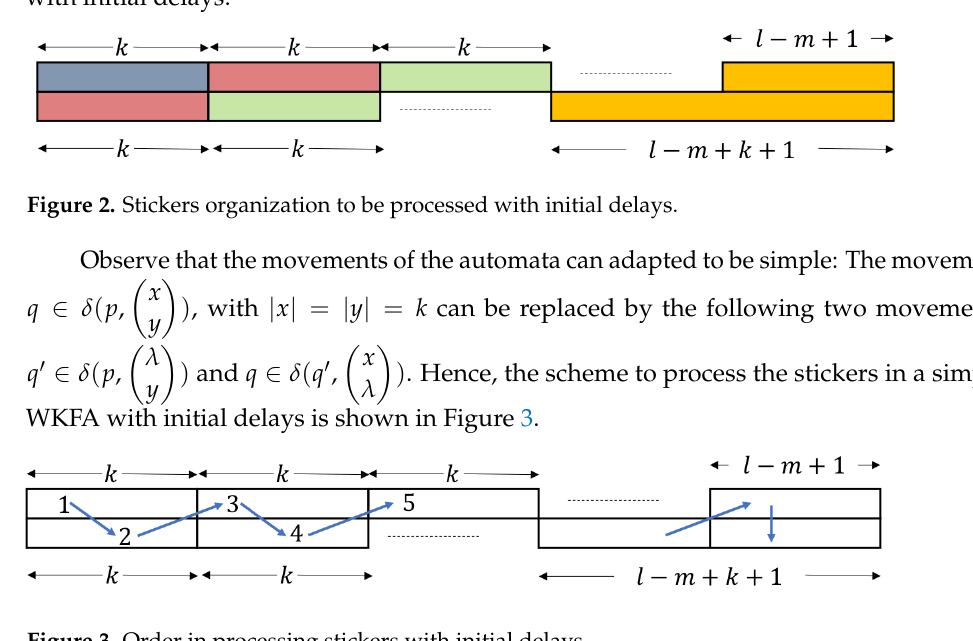
Figure 3. Order in processing stickers with initial delays.